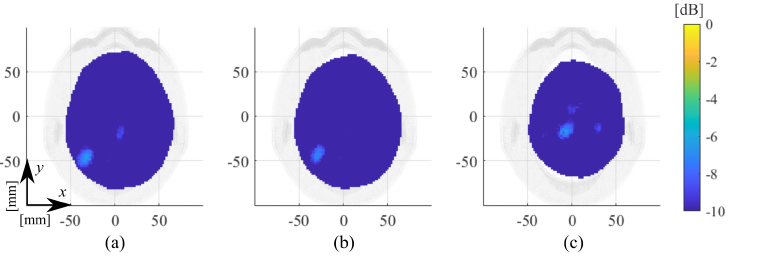
Figure 15. Amplitude values of the reconstructed dielectric contrast for false-positive scenarios in the case of different time intervals in the MTP case; transverse views cut in their maximum, normalized to the maximum value of ICH-MTP_1: ( a ) 35min, ( b ) 1 h and 45min, and ( c ) 1 h and 10min.